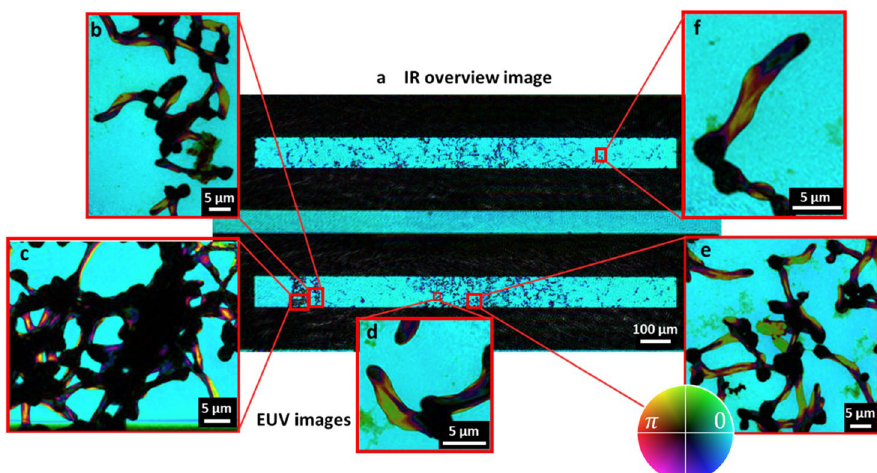
Fig. 2 IR and EUV complex reconstruction of A. nidulans . a Reconstruction of the entire Si 3 N 4 membrane using the fundamental IR beam. The FOV of the reconstruction is 0.9 mm 2 . b ‑ f show the reconstructed complex EUV images measured using a narrow spectrum from the generated high-order harmonics of the driving IR beam. In b , c , and e , clusters of hyphae are observed, while d and f show the structure of a single hypha. The image brightness represents the transmitted amplitude, and the hue represents the